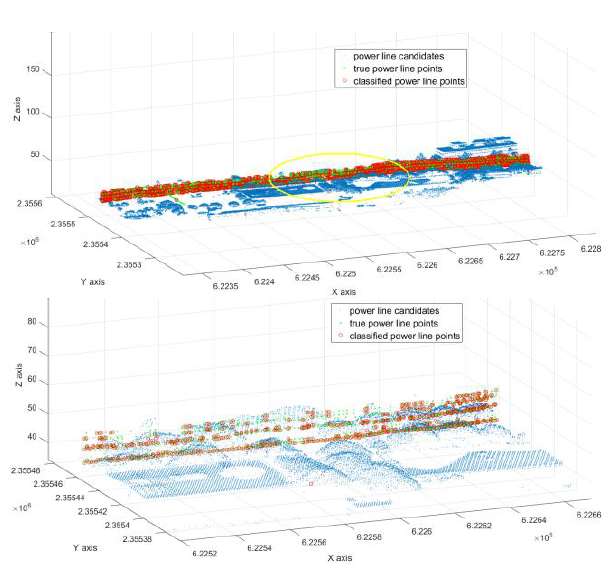
Figure 4. Visualisation of the experiments results for power line classification of LP Dataset (top) and the local magnification of the yellow ellipse area